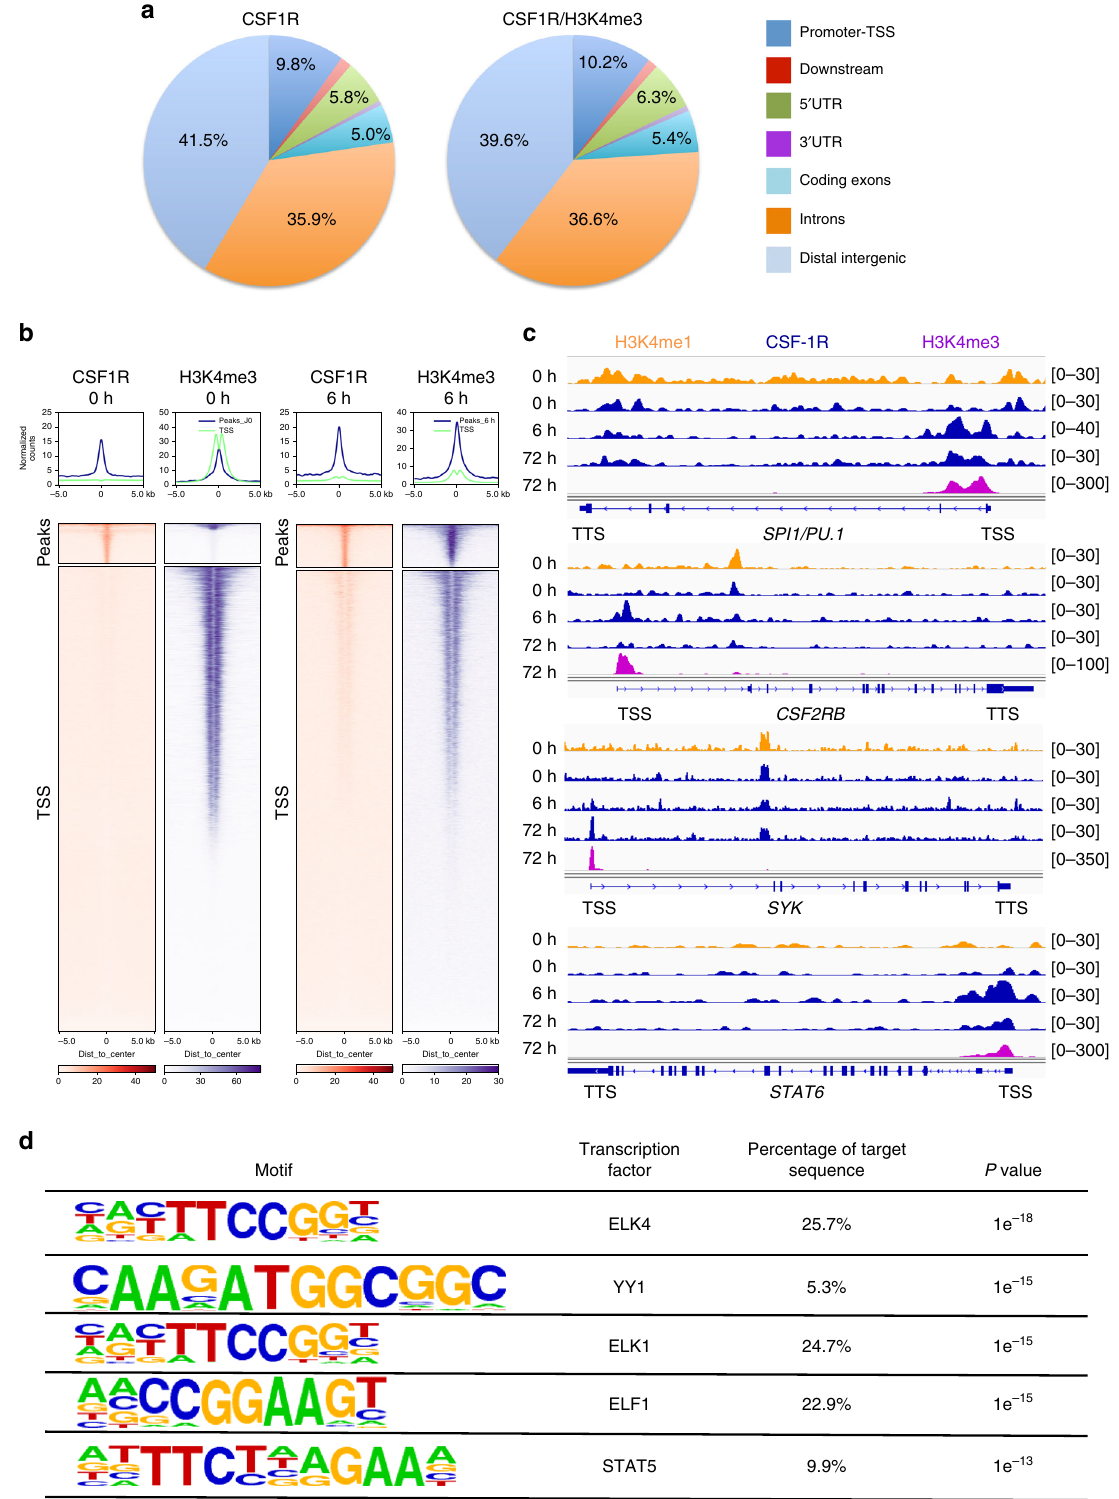
Fig. 8 CSF-1 modulates CSF-1R recruitment on chromatin within a few hours. a Repartition of CSF-1R ChIP-seq peaks and the intersection of CSF-1R and H3K4me3 peaks on the genome of monocytes exposed for 6 h to 100 ng/mL CSF-1. Reference genome is shown on Fig. 3b. b Heatmap centered on CSF-1R peaks (top) and on gene transcription starting sites (TSS) of CSF-1R and H3K4me3 peaks in unstimulated monocytes (0 h) and monocytes exposed to CSF-1 for 6 h (6 h). c ChIP-Seq experiments showing CSF-1R, H3K4me1 and H3K4me3 peak localization on PU.1, CSF2RB , SYK and STAT6 genes in monocytes, either untreated (0 h) or treated with CSF1 for 6 h (6 h) or 3 days (72 h) (TSS: transcription starting site, TTS: transcription termination site). d Motif analysis of the CSF-1R ChIP-seq peaks from monocytes stimulated with 100 ng/mL CSF-1 for 6